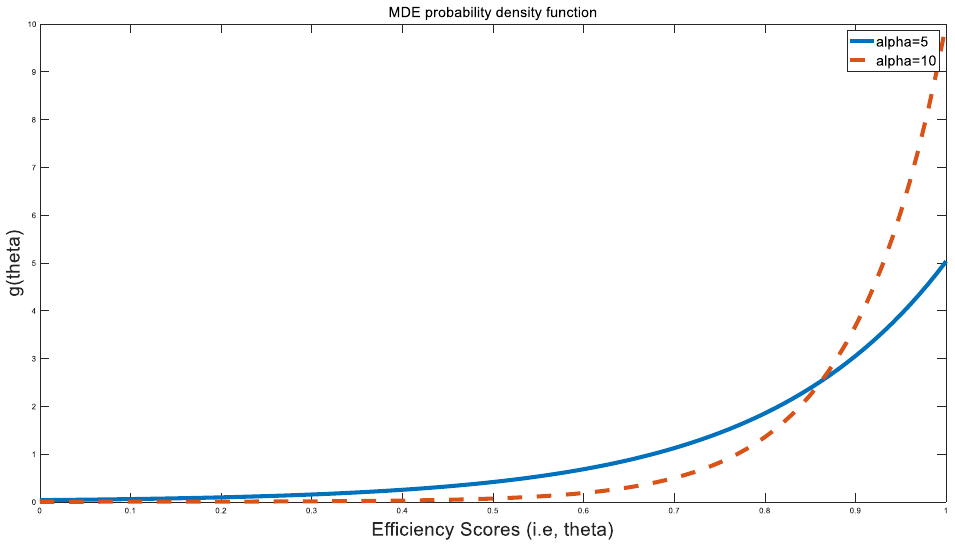
Figure 5. The maximum decisional efficiency (MDE) probability density function (pdf) for α = 5 and α = 10, respectively.